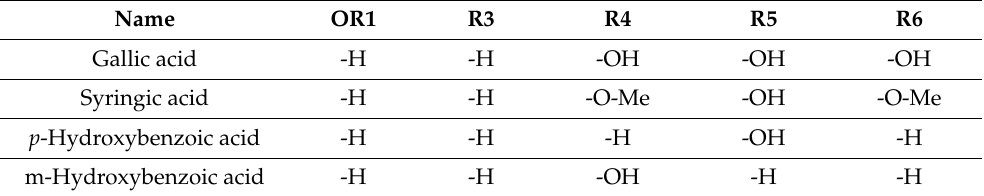
Figure 4. Basic structure of Hydroxycinnamic acid and its derivatives. Table 4. Hydroxybenzoic acid and its derivatives reported in clover plants and honey (see Figure 5 for general structure).